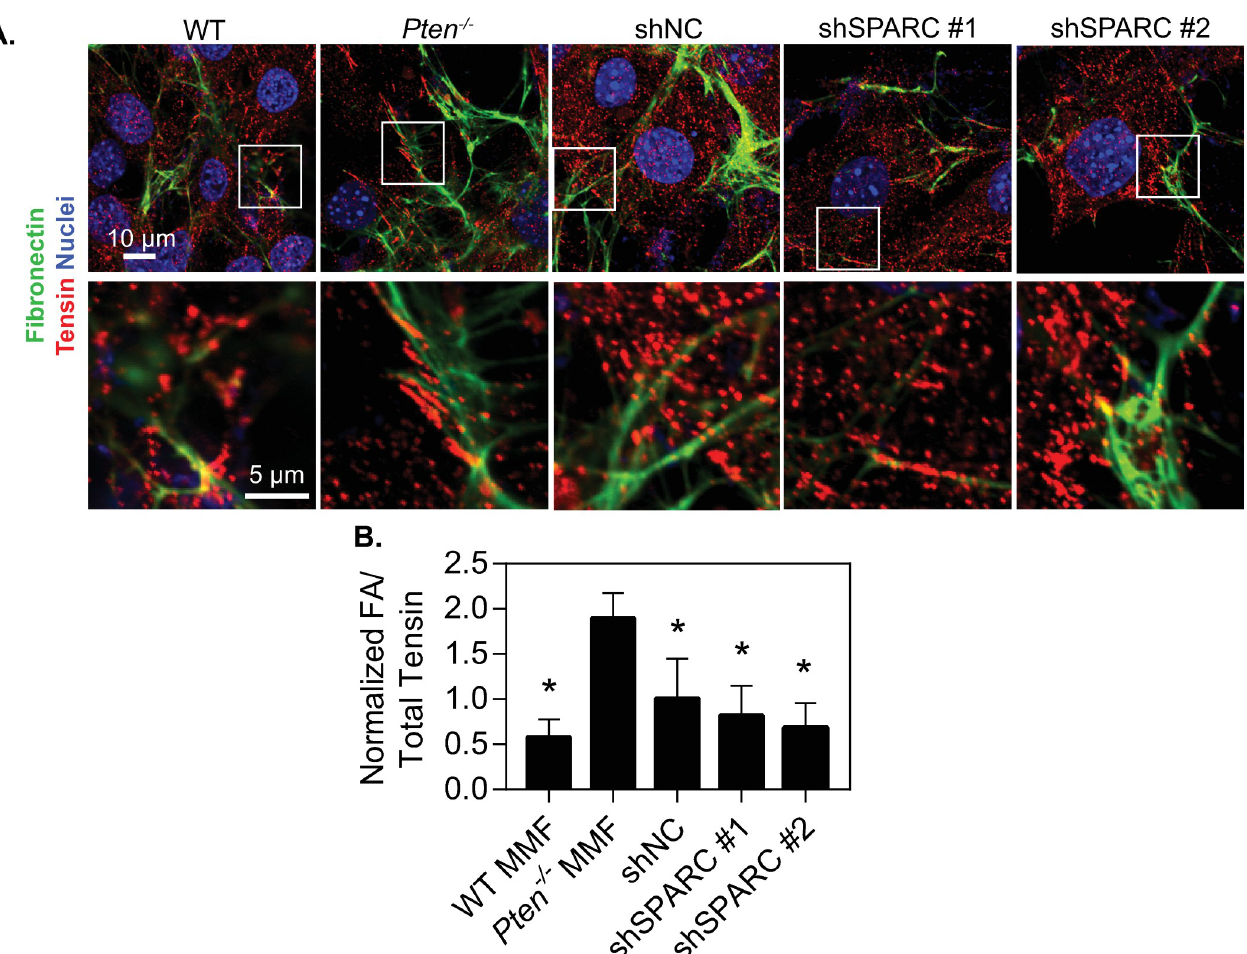
Fig 7. SPARC expression induced by Pten knockout promotes fibrillar adhesion formation. (A) Top row: Immunofluorescence images of cells incubated with fluorescently labeled fibronectin for 24 hours, then fixed and stained for tensin and nuclei. Inset boxes indicate areas of interest, magnified in bottom row. (B) Quantification of the number of fibrillar adhesions (FAs) per field of view (FOV) relative to the total amount of tensin signal present. n = 3+SD. #p < 0.05 relative to Pten -/- .